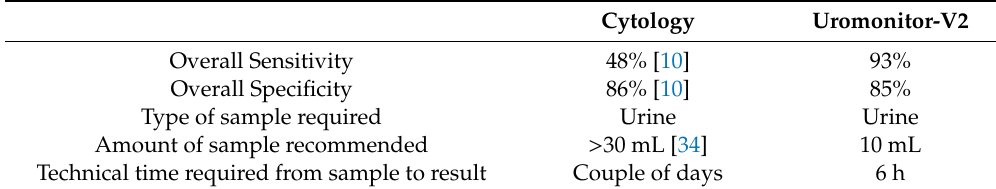
Table 4. A summarized description of the Uromonitor-V2 ® test characteristics and requirements compared with